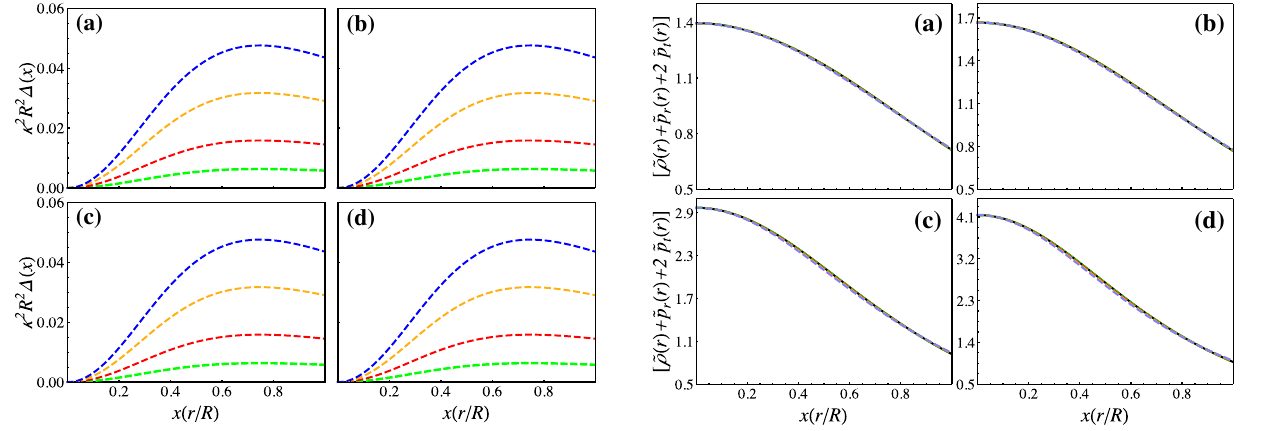
Fig. 6 Strong energy condition, for a u = 0 . 13, b u = 0 . 15478, c u = 0 . 2035, d u = 0 . 229365. α = 0 (black solid line), α = 0 . 04, (green dashed line), α = 0 . 1 (red dashed line), α = 0 . 2 (yellow dashed line), α = 0 . 3 (blue dashed